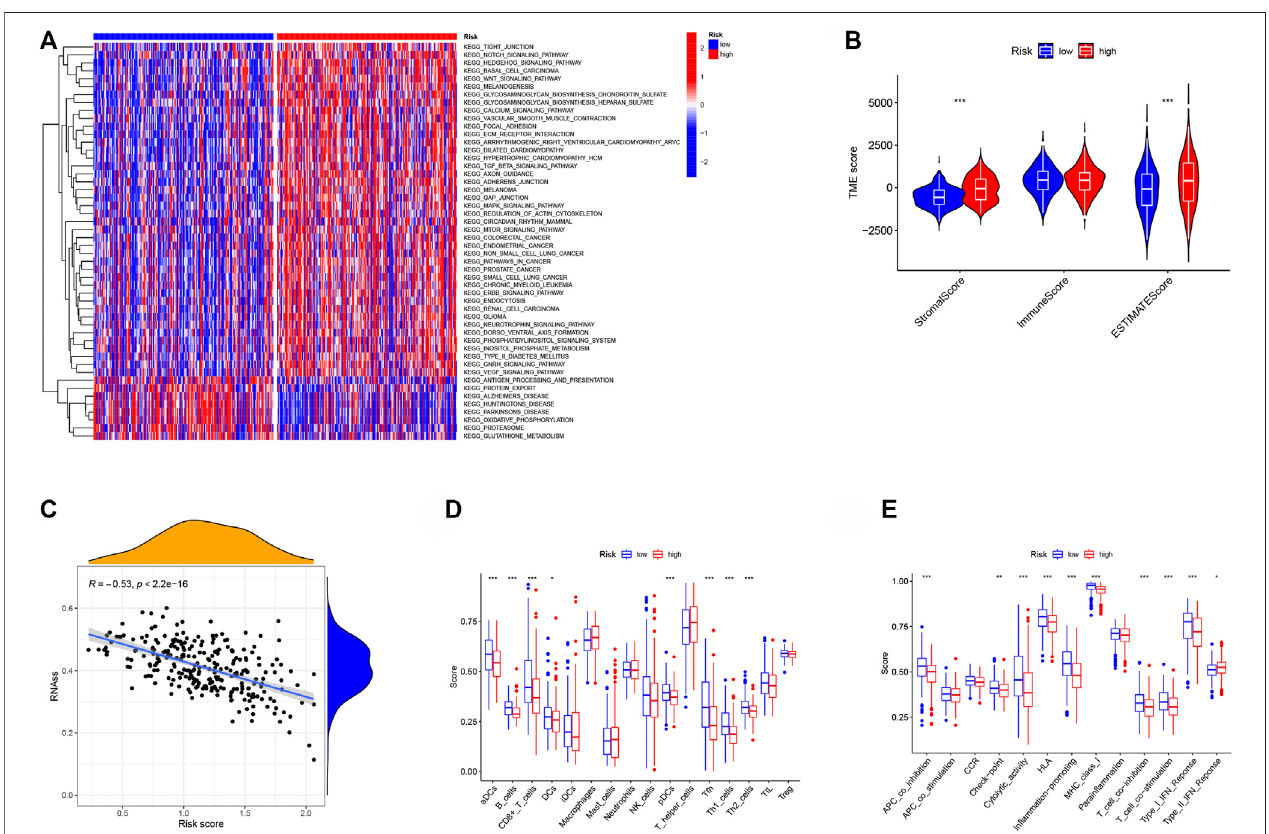
FIGURE 7 | The relationship between RS and tumor microenvironment. (A) GSVA enrichment analysis shows the activation states of biological pathways in different subtypes. The heat map was used to visualize these biological processes, and red represented activated pathways and blue represented inhibited pathways. (B) Comparison of TME scores between low- and high-risk groups. (C) The relationship between RS and RNAss. (D) Comparison of the in fi ltration of 16 immune cells between low- and high-risk group. (E) Comparison of the immune functions between low- and high-risk group. * p < 0.05, ** p < 0.01, *** p <